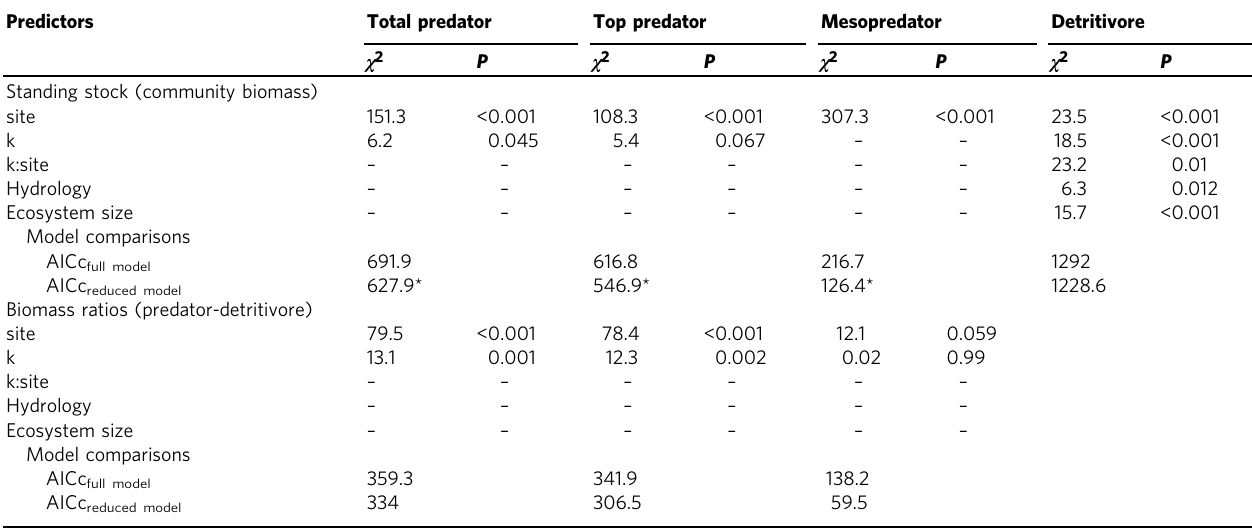
Table 1 Main statistical results.